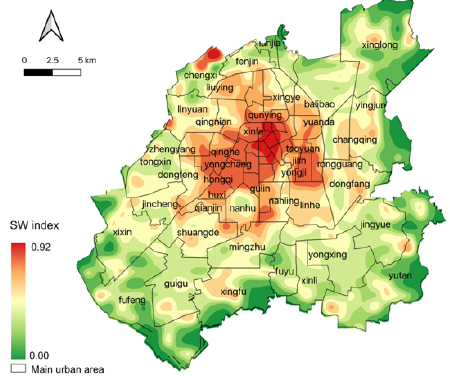
Figure 10. Spatial distribution of service facility diversity.